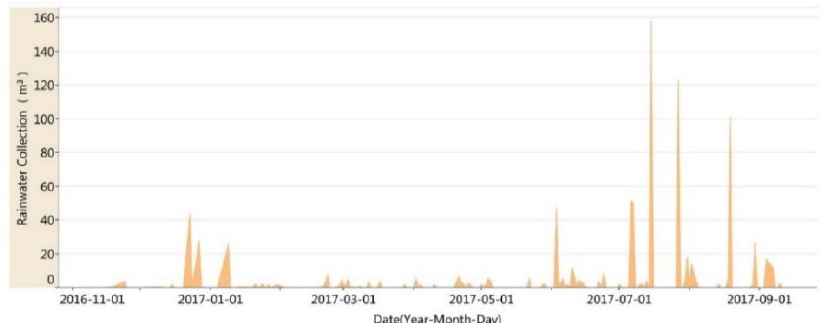
Figure 6. UGI daily rainwater harvesting statistics on site from November 2016 to October 2017.